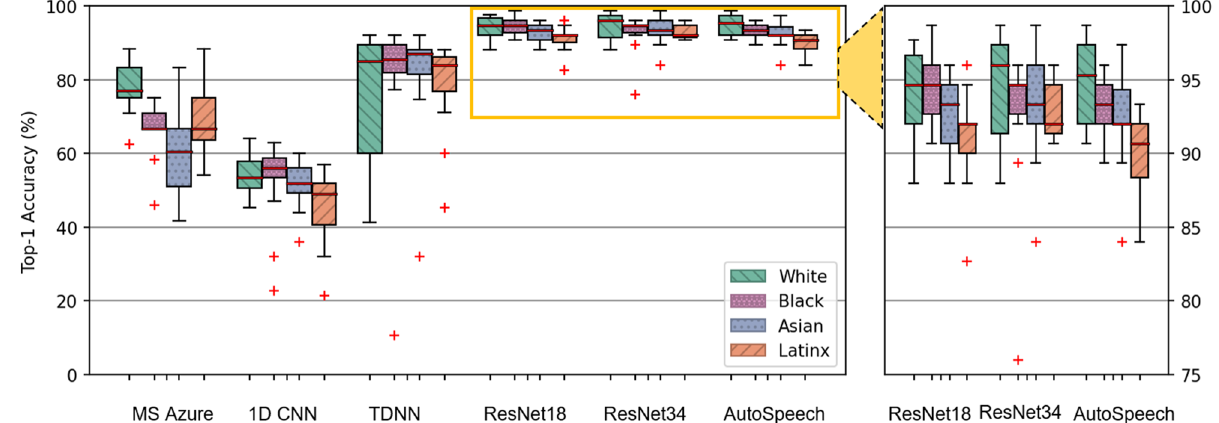
Figure 4. Voice identification performance among the matched racial dataset. The x-axis is racial subgroups ( W White, B Black, A Asian, L Latinx). The y-axis is the percentage accuracy. ResNet-34 has the best overall accuracy. Significant differences exist among all data or between sub-groups in Microsoft Azure, 1d-CNN, ResNet-18, and AutoSpeech. No significant differences in TDNN and are shown in Fig. 4. The average Top-1 accuracy for White speakers is 77.58% (STD 7.53%) higher than with Latinx (69.67%, STD 9.81%), black (65.83%, STD 8.29%), Asian (61.22%, STD 13.13%) speakers, respectively. A significant difference exists among all subgroups on the whole (p < 0.01), and the performance on White speakers is outstandingly higher than Black and Asian subgroups (p < 0.01, 95% CI 4.31, 19.19; p < 0.01, 95% CI 6.31, 26.42), respectively. Since this commercial product is black-box (the details about this voice biometric model or other related knowledge are not accessible to the public) and contains the racial disparity in the related application (the related functionality (speech recognition) in cognitive services from Microsoft Azure has been reported containing racial bias 7 ) due to unbalanced training data samples, we continue exploring the racial dis- parity with the following representative open-source models. For the open-source products, we build the speaker identification systems from the sketch under the default settings from its original paper based on our matched dataset. There are mainly two types of voice biometric products. Except for the neural network-based type mentioned in the following, the statistic-based type for